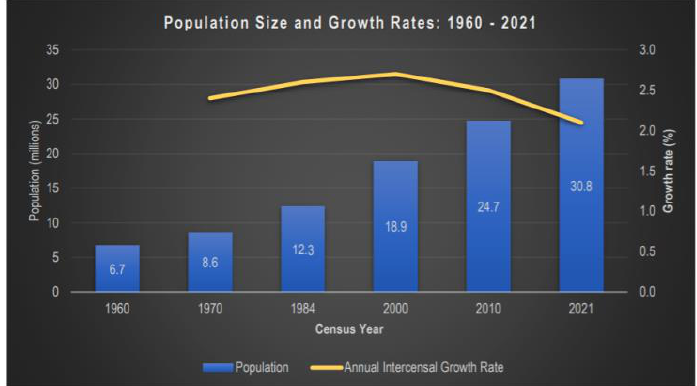
Figure 2 : Population Size and Growth Rates of Ghana from 1960 To 2021; Source: Ghana Statistical Service, 2021. Poverty, unemployment and Global Entrepreneurship Index (GEI) in Ghana